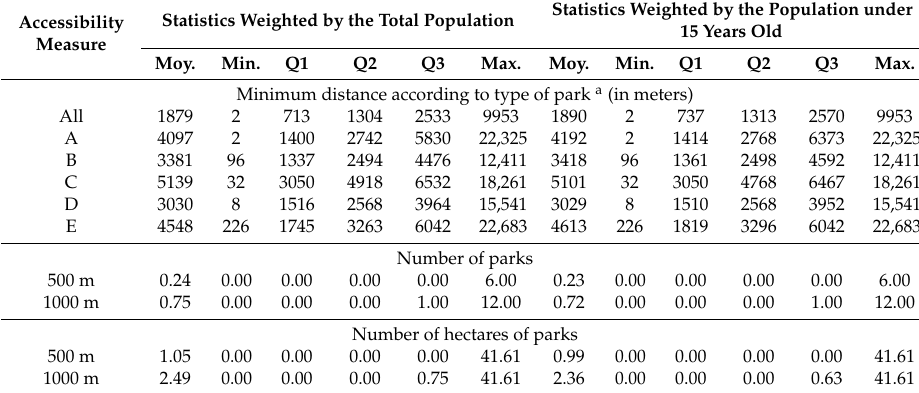
Table 4. Univariate statistics of accessibility measures at ward level.